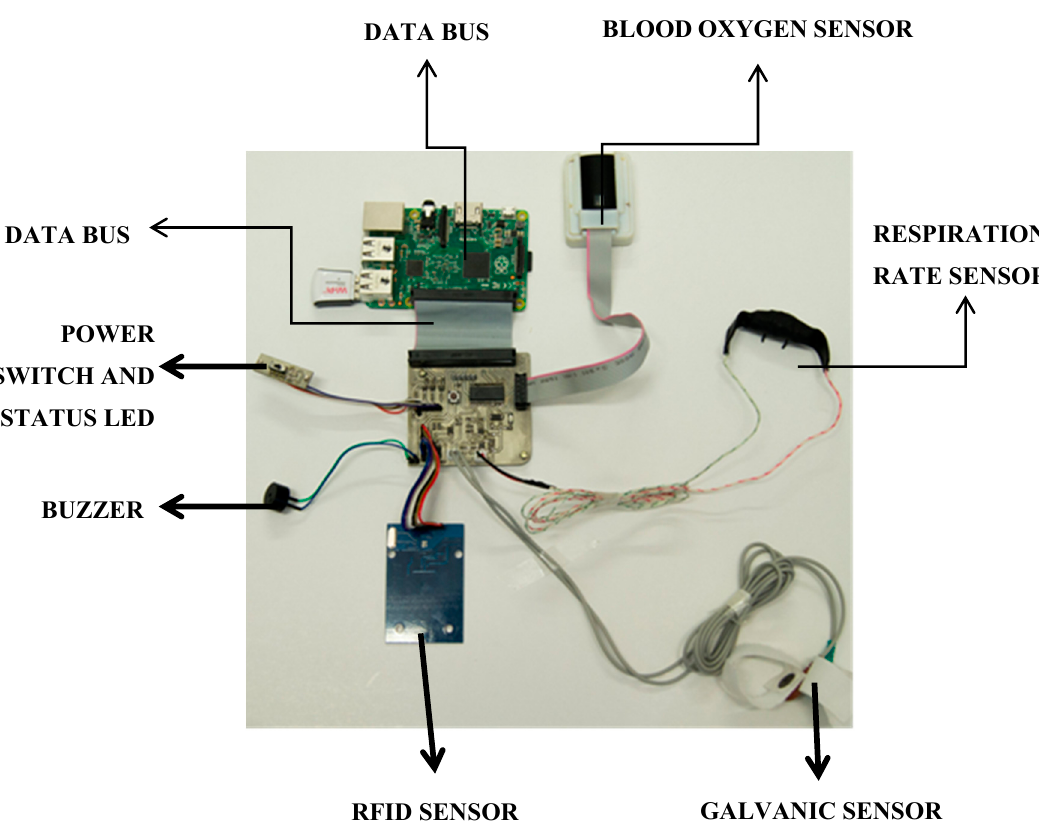
Figure 2. PlaIMoS fixed measurement station hardware.